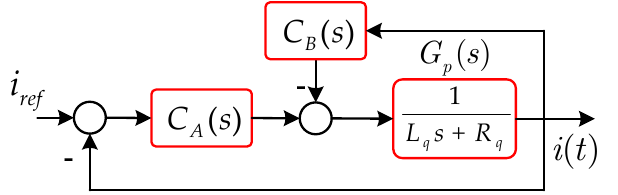
Figure 1. Diagram of the robust two degrees-of-freedom (Robust−TDOF) controller.